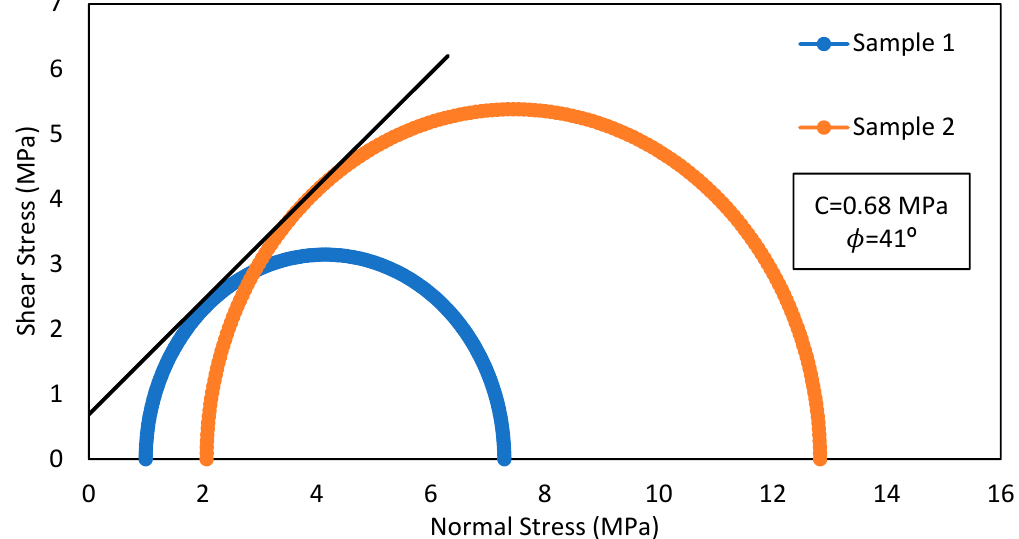
Figure 7. Failure envelope and Mohr’s circles of 3D printed rocks made up of gypsum powder. Cohesion (C) is 0.68 MPa and internal friction angle ( 𝜙 ) is 41°.